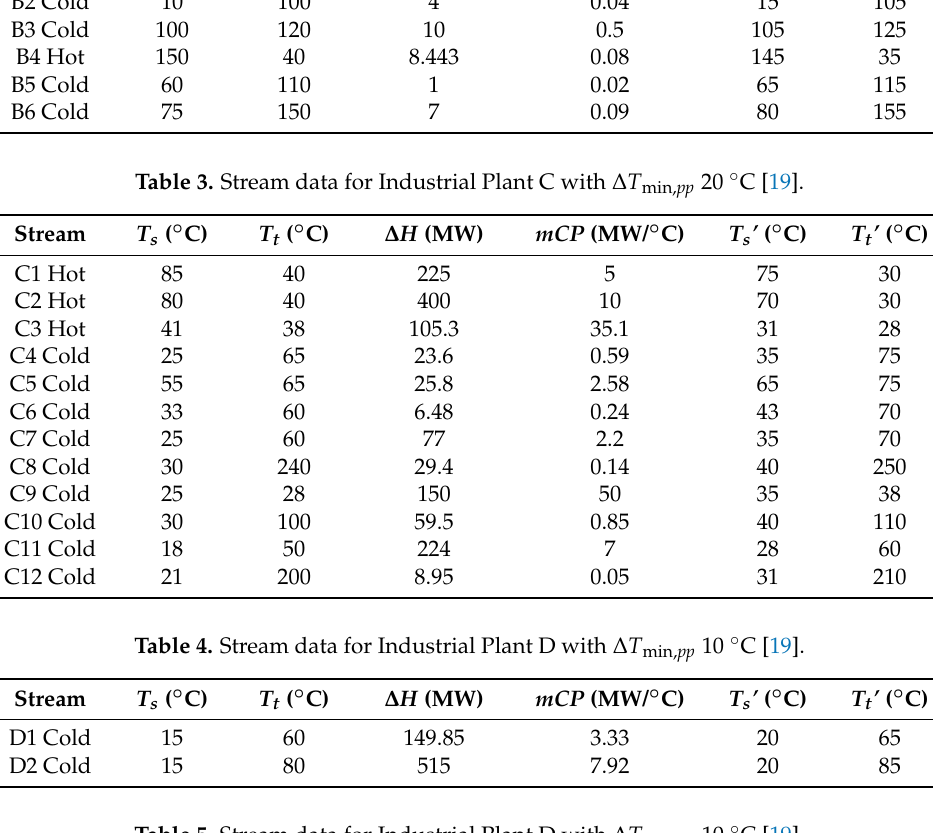
Table 5. Stream data for Industrial Plant D with ∆ T min, pp 10 ◦ C